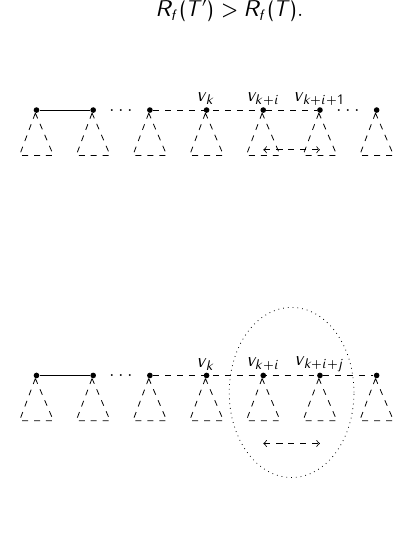
Figure 3. Case (2-a)